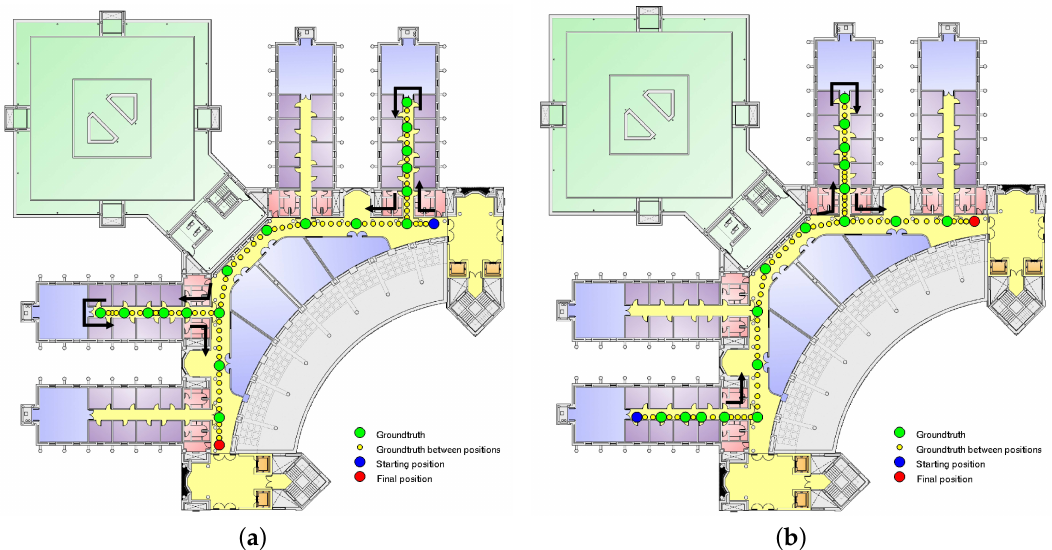
Figure 9. Trajectories used to test the proposed CSE method. ( a ) Trajectory 1; ( b ) Trajectory